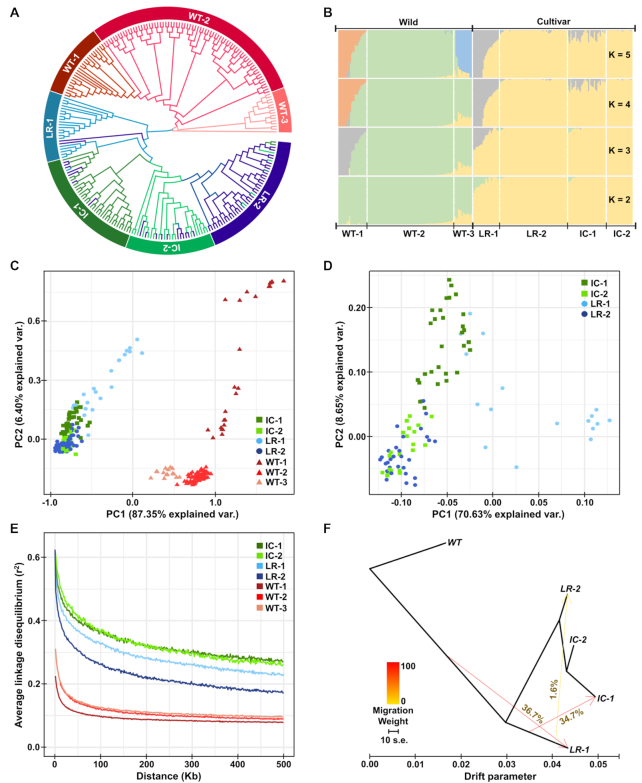
Genomic relationship between IC, LR, and WT, including their subgroups. A, Phylogenetic tree inferred by the randomized and accelerated maximum likelihood method based on sequence alignments of all accessions. B, Population structure calculated by the maximum likelihood–based clustering algorithm. C, D, PC analysis plots for all groups and cultivar groups, calculated on the basis of genetic diversity. E, The extent of LD decay calculated up to 500 kb. F, Maximum likelihood tree for the relationships of the gene flow and genetic drift between the subgroups. The x-axis indicates the strength of genetic drift. The 3 arrows show the gene flows and migration rates derived from source groups, and the scale bar represents the standard error. The whole WT group was used as 1 root group in order to focus more on interactions among IC and LR subgroups while minimizing the standard error.